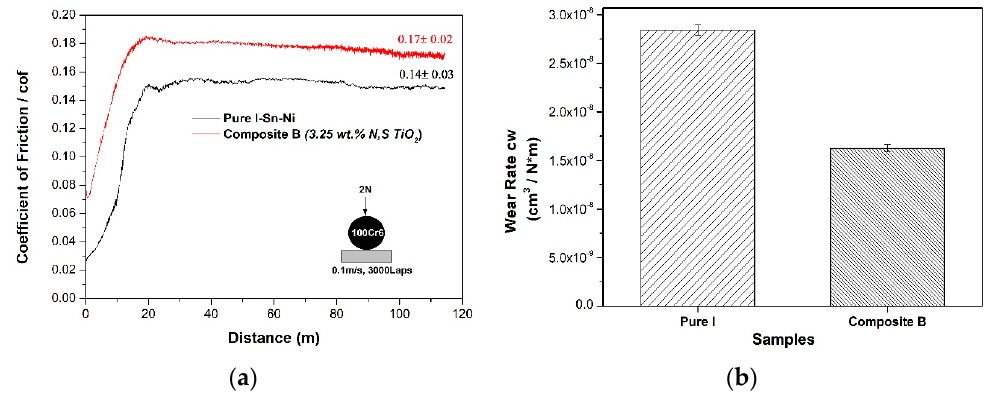
Figure 12. ( a ) Evolution of friction coefficient for pure SnNi (sample I) and composite SnNi/N,S-TiO 2 coating (Sample B) sliding against 100Cr6 ball ( d = 6 mm) and ( b ) Volumetric wear factor values of pure SnNi (Sample I) and composite SnNi/co-doped N,S-TiO 2 (Sample B) coatings after sliding against 100Cr6 ball ( d = 6 mm).